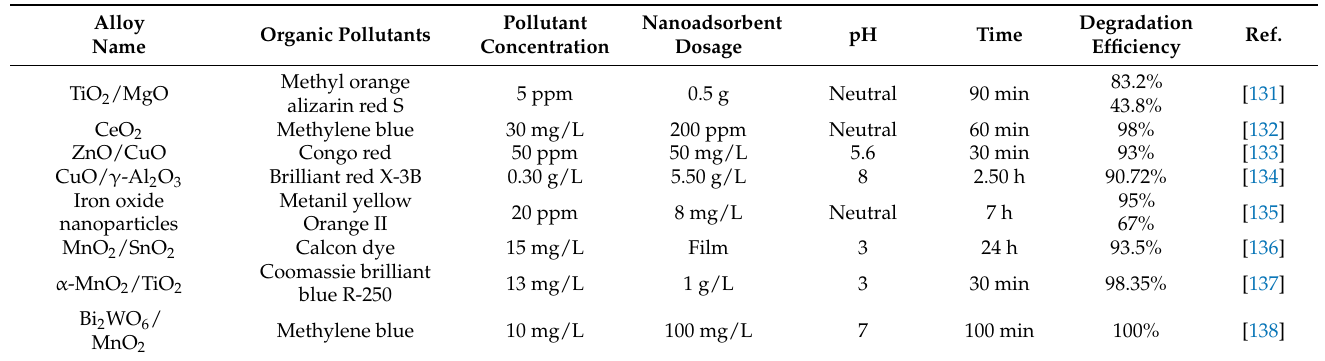
Table 4. Azo dye degradation with oxide-based